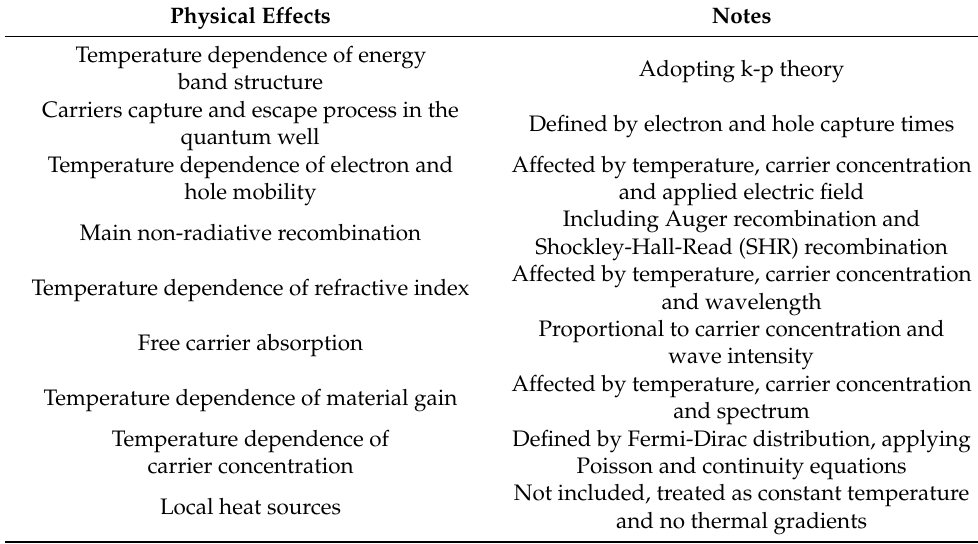
Table 1. Main physical effects included in the